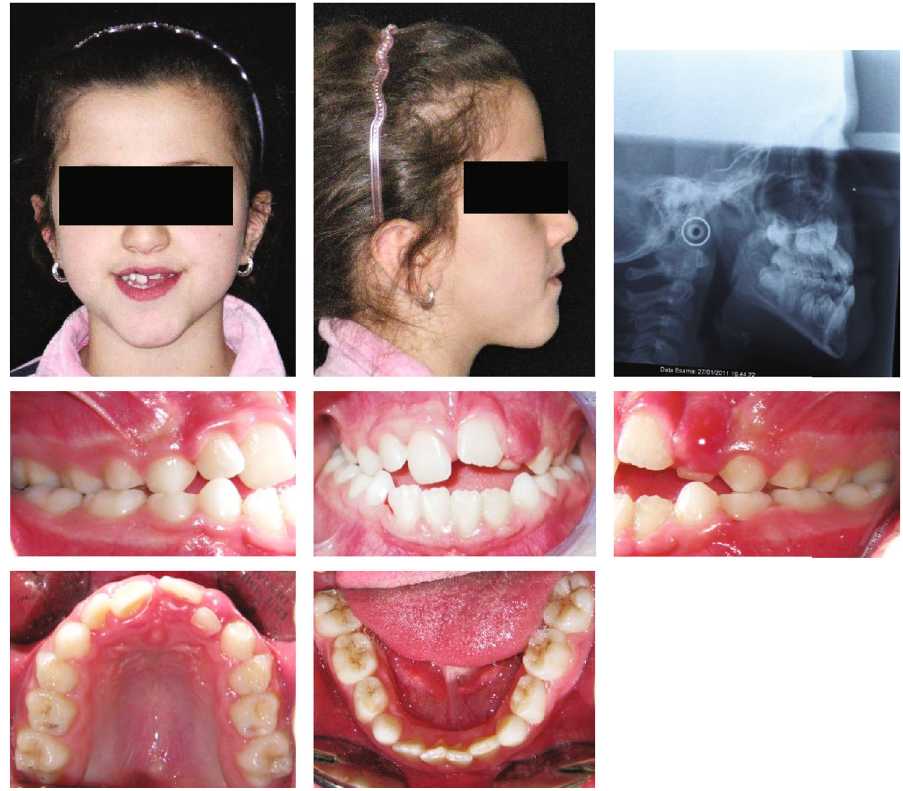
Figure 10: Case no. 2 facial photos, intraoral photos, panoramic radiograph, and lateral cephalogram at T